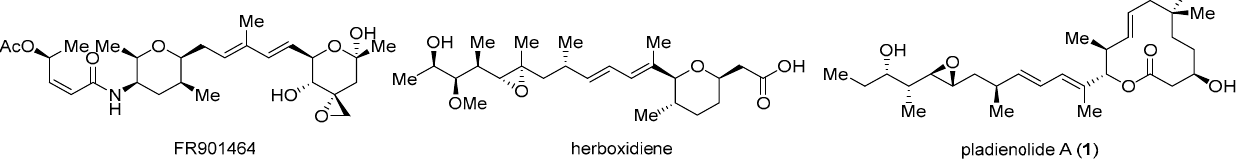
Figure 1. Representative examples of naturally occurring spliceosome modulators.